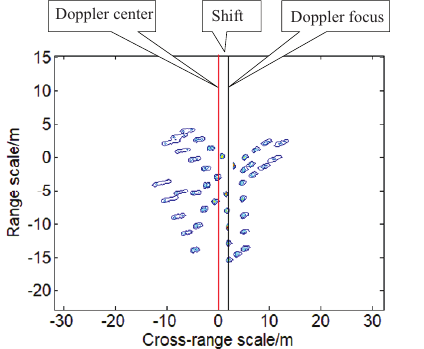
Figure 2. Representation of Doppler focus